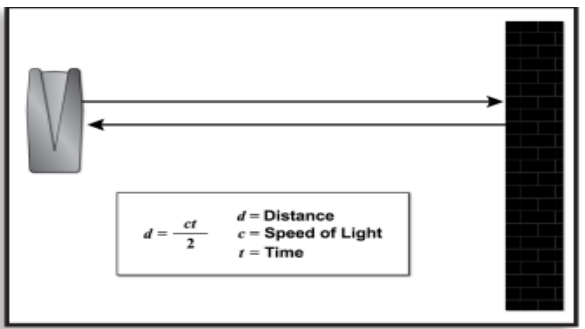
Figure 4. The working principle of time-of-flight measurements